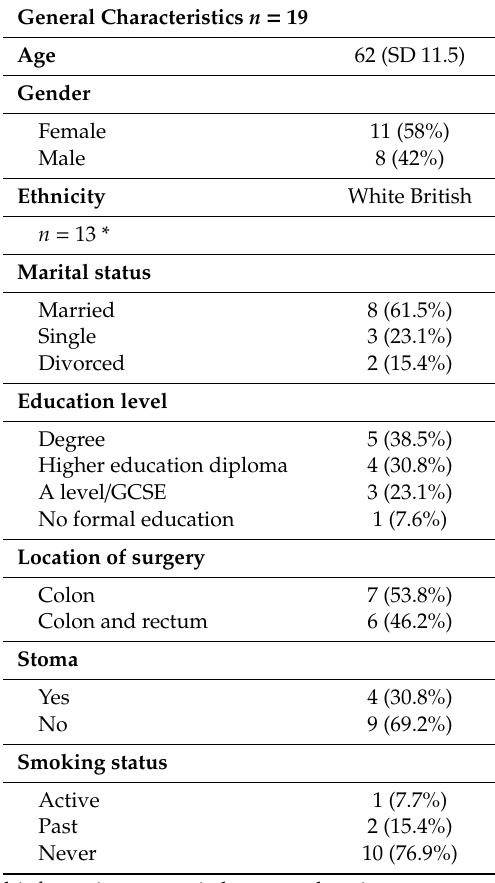
Table 1. Characteristics of survivors of CRC.